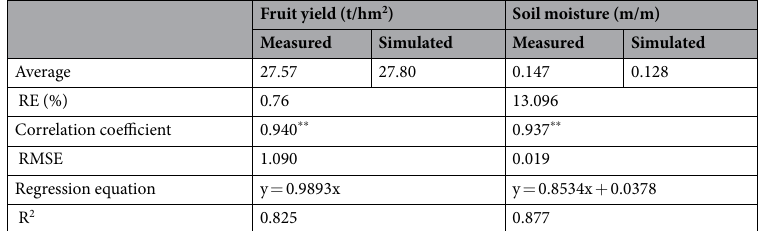
Table 5. Simulated and measured yield and soil moisture of apple orchards in Luochun.